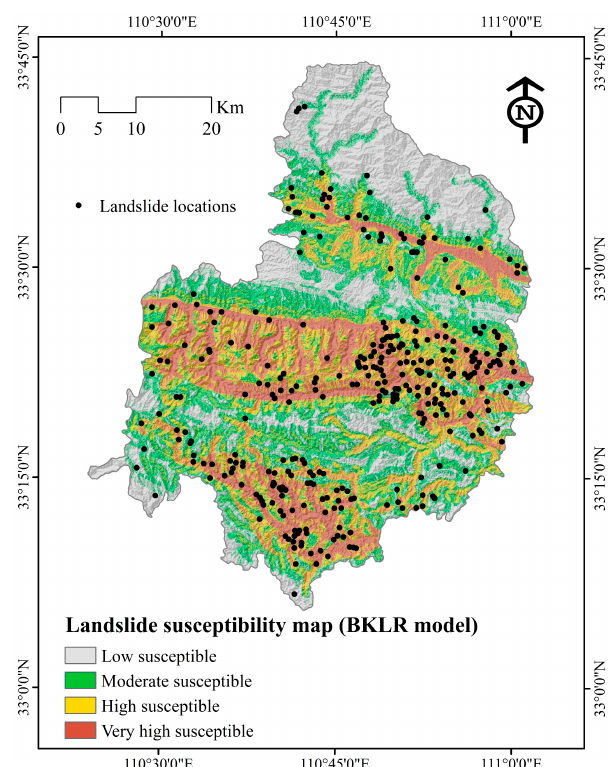
Figure 5. Landslide susceptibility map using the bagging-based two-class kernel logistic regression (BKLR) model.